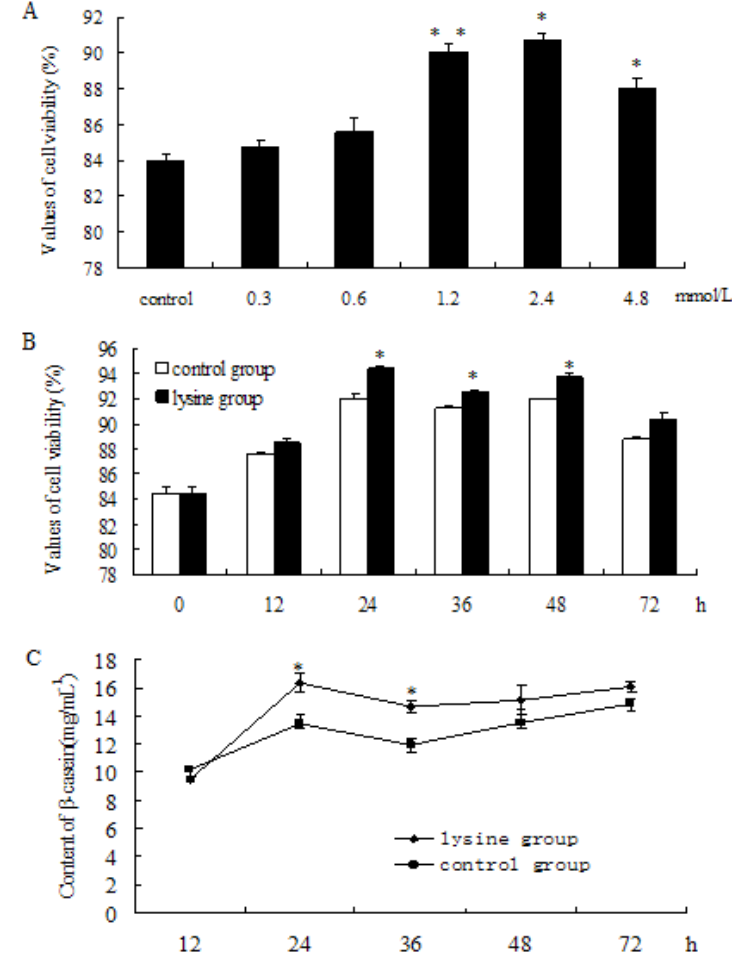
Figure 1. Detection of cell viability and β -casein secretion of DCMECs treated with L -Lys. ( A ) Viability of cells at 24 h after adding L -Lys (0, 0.3, 0.6, 1.2, 2.4, 4.8 mmol L − 1 ); ( B ) Viability of cells at 0, 12, 24, 36, 48, 72 h after adding L -Lys 1.2 mmol L − 1 ; ( C ) Changes of β -casein content of DCMECs at 12, 24, 36, 48, 72 h after adding L -Lys 1.2 mmol L − 1 . Values are means ± SE (n = 3 per group, biological replicates). * and ** indicate significant differences from values obtained in the control group at the same time point at levels of p < 0.05 and p < 0.01,